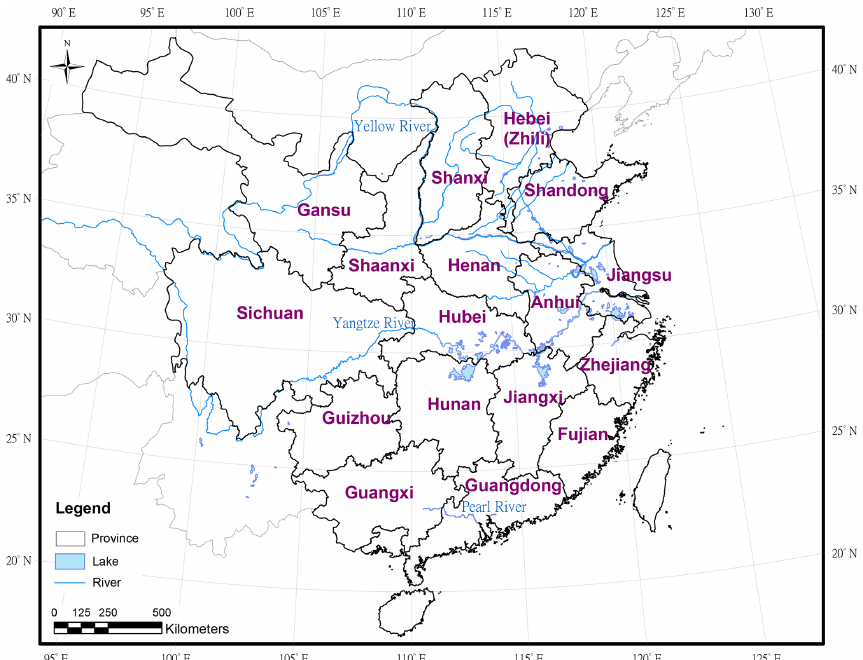
Figure 6. Provincial boundaries and names in the eastern part of China. The basic latitude and longitude grid map is from the Esri data set, and provincial and city and county boundary and river shapefiles are from the Chinese State Bureau of Surveying and Mapping, Digital Map Database of China (1990